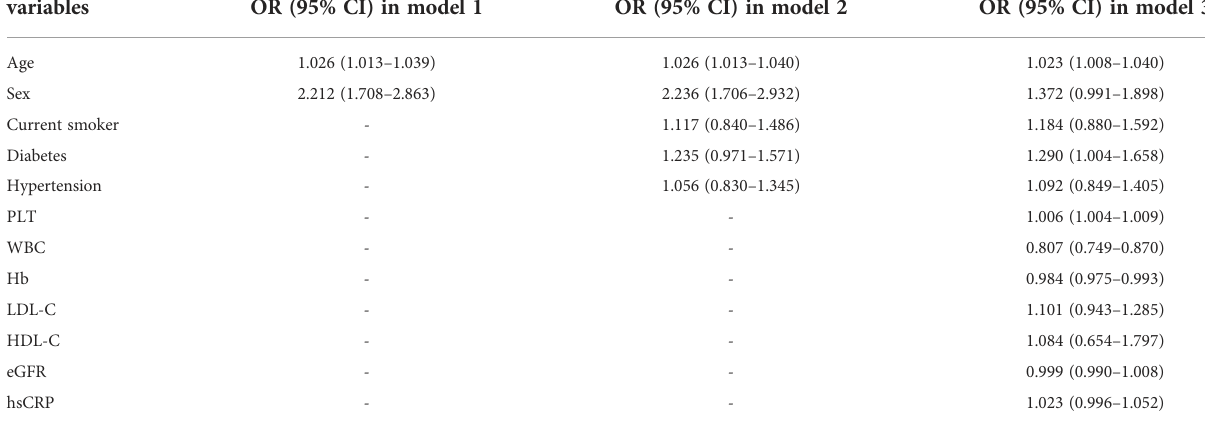
TABLE 4 ORs (and 95% CIs) for HRPR of other variables.